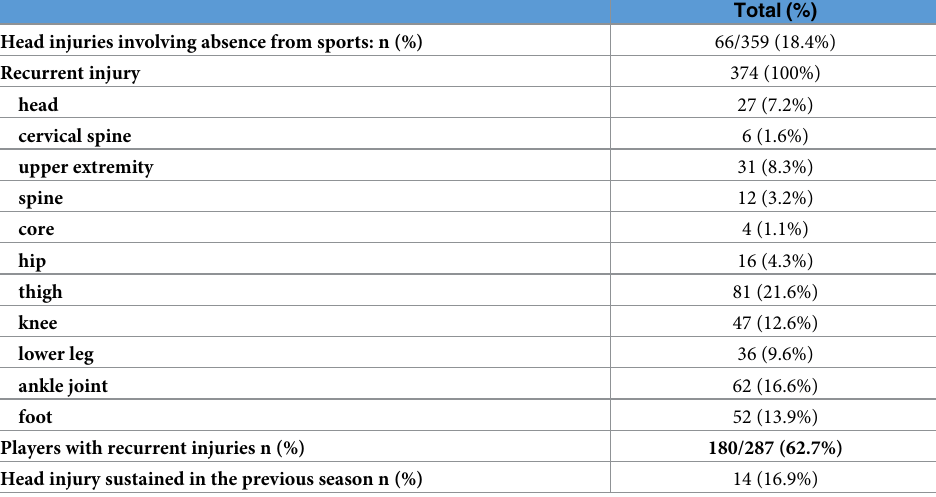
Table 4. Medical consequences after head injuries registered with the accident